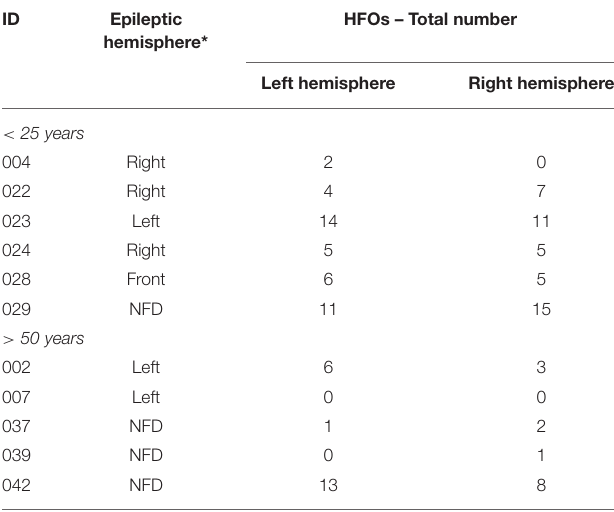
TABLE 4 | Diagnosed epileptic hemisphere and absolute HFO